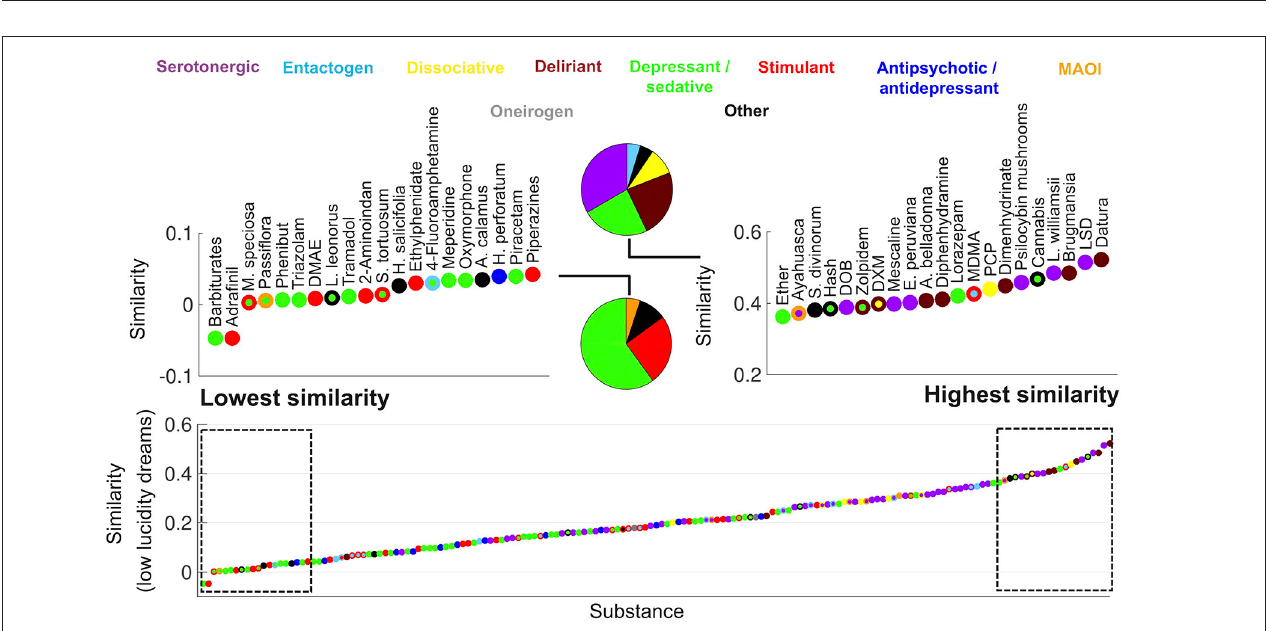
FIGURE 1 | Ranking of psychoactive substances in the Erowid corpus in terms of the similarity of their subjective reports to those of high lucidity dreams (Dreamjournal corpus). The rectangles on the left/right zoom into the top 20 lowest/highest ranking substances and the pie charts indicate the proportion of each primary category. Substances are represented with circles that are color-coded based on their category (the color of the center/border corresponds to the primary/secondary category).